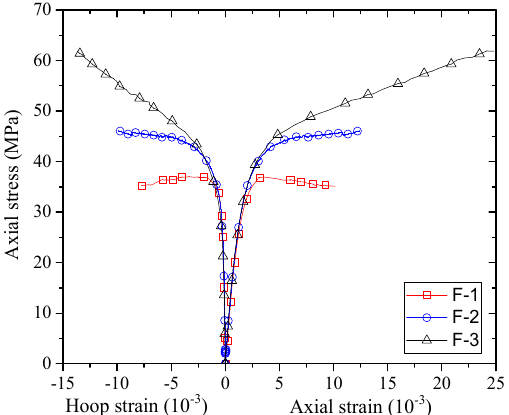
Figure 7. Stress–strain curves of concrete in the Group I specimens.